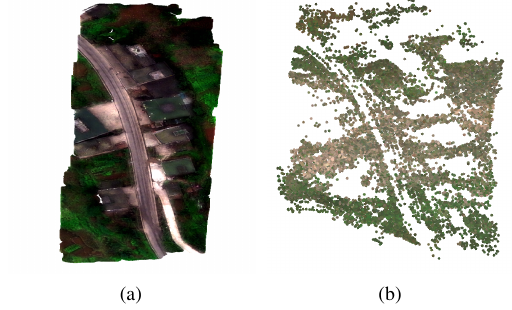
Figure 5. (a) RGB display of the study area. (b) RGB display of the new point